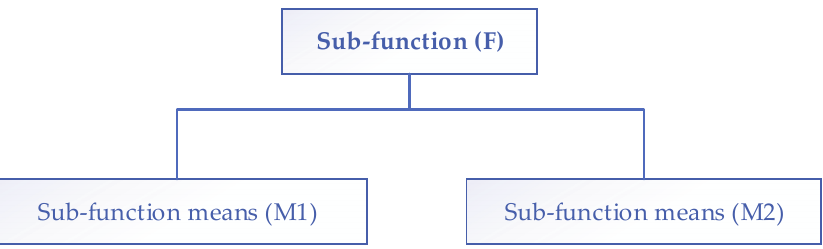
Figure 3. The form of sub ‐ functions means (competitors)